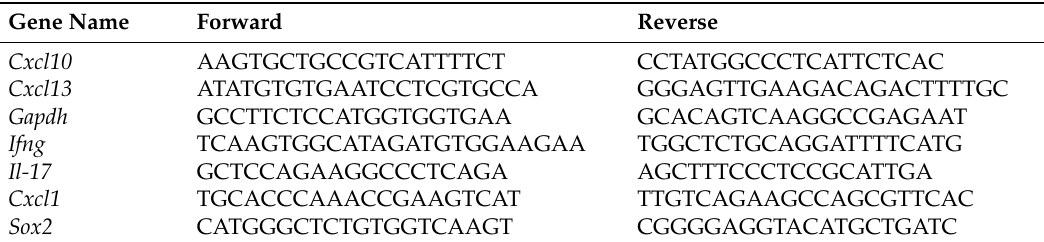
Table 1. Sequence of the primers used in this study.